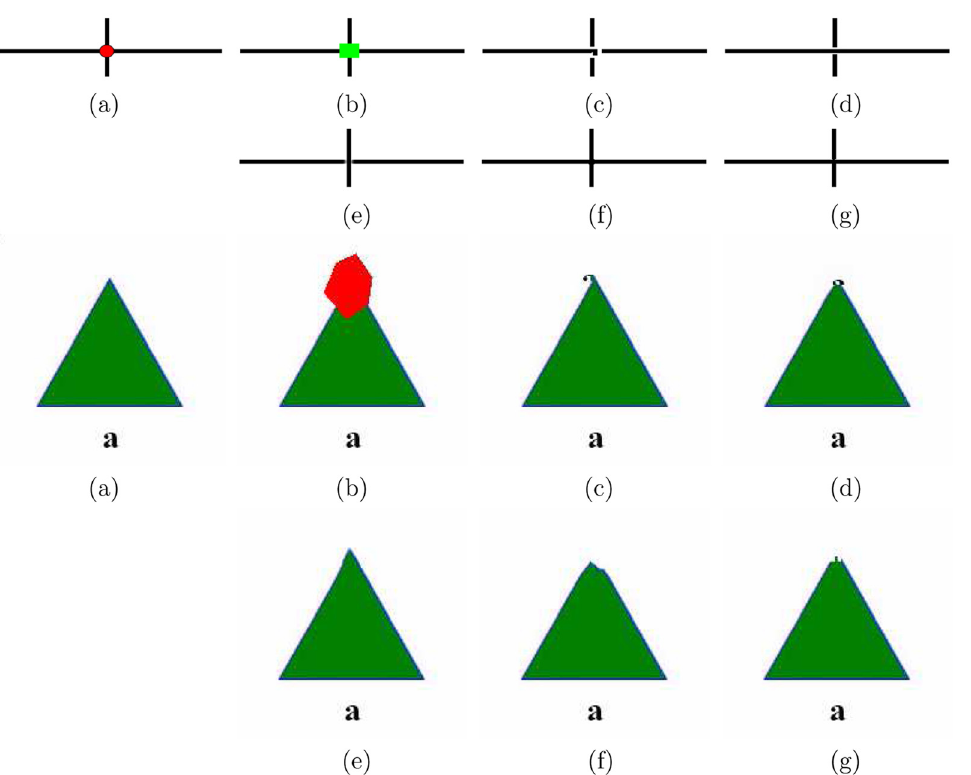
Fig 13. Test images from top to bottom: “ cross-shape ” (110 × 317) and “ triangle ” (182 × 184). (a) The original images; (b) The original images with the red target regions; (c) Criminisi ’ s method “ 04 ’ TIP ” [23]; (d) The method “ 07 ’ TPAMI ” by Wexler et al. [18]; (e) Photoshop CS5 [16]; (f) The method “ 13 ’ TIP ” by Liu et al. [19]; (g) The proposed